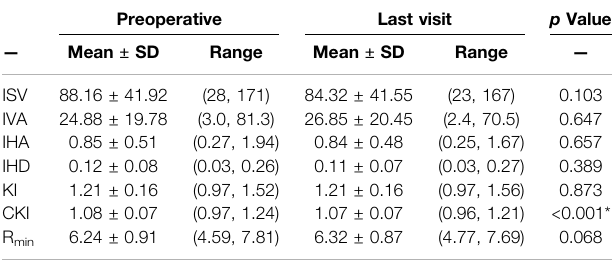
TABLE 3 | Topography indices